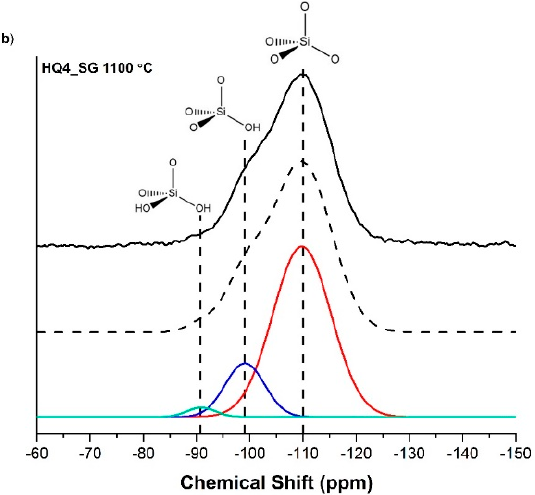
Figure 6. 29 Si MAS NMR for HQ4_SG samples with peaks at ~ − 110 ppm, − 100 ppm and − 92 ppm, corresponding to SiO 4 , SiO 3 (OH) and SiO 2 (OH) 2 tetrahedra, respectively; for ( a ) the sample pyrolyzed to 800 °C and ( b ) the sample pyrolyzed to 1100 °C.